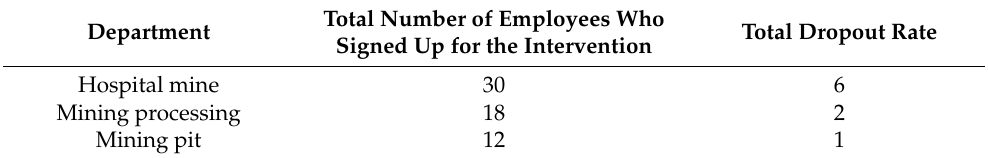
Table 3. Employees reached at the